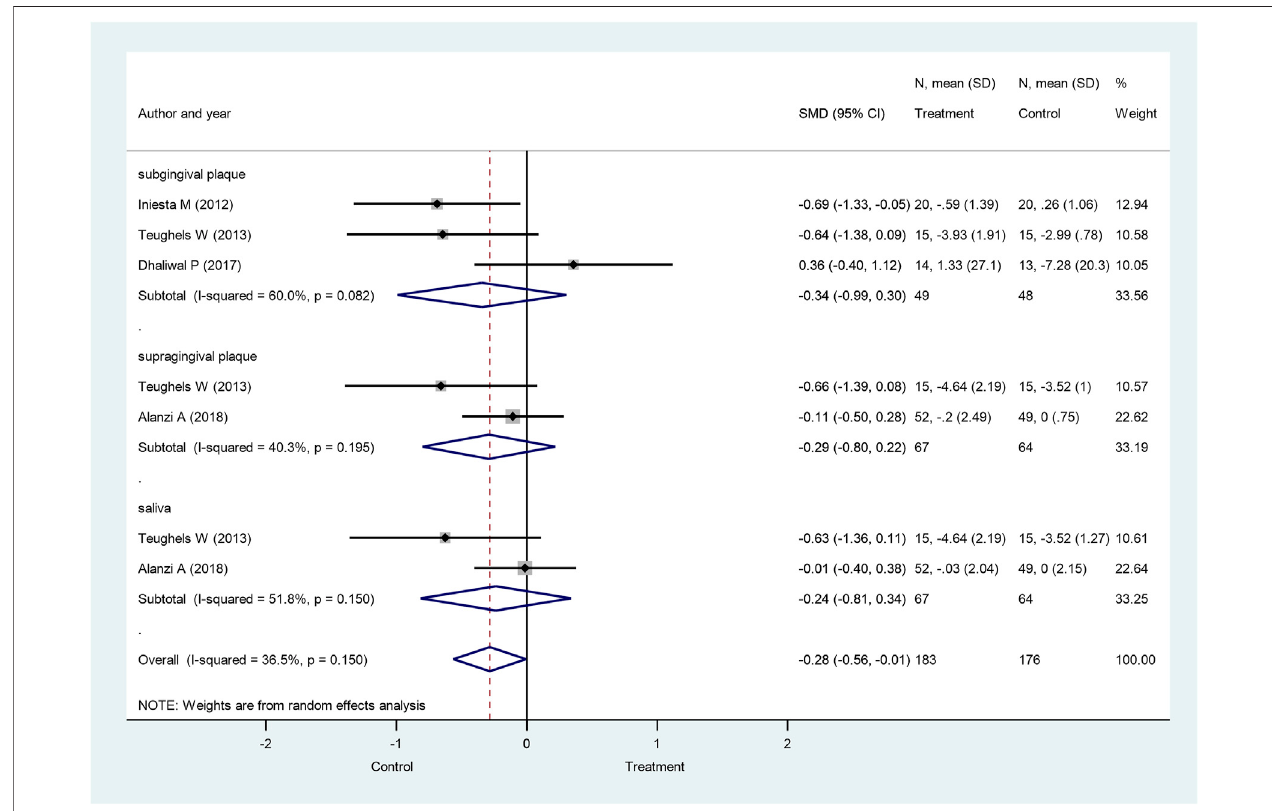
FIGURE 3 | Forest plot analysis of the change in Aggregatibacter actinomycetemcomitans at 4 weeks. The overall result presented a signi fi cant decrease of Aggregatibacter actinomycetemcomitans in the treatment group compared to the control group (SMD: − 0.28; 95% CI: − 0.56 – − 0.01; p (cid:2) 0.045).